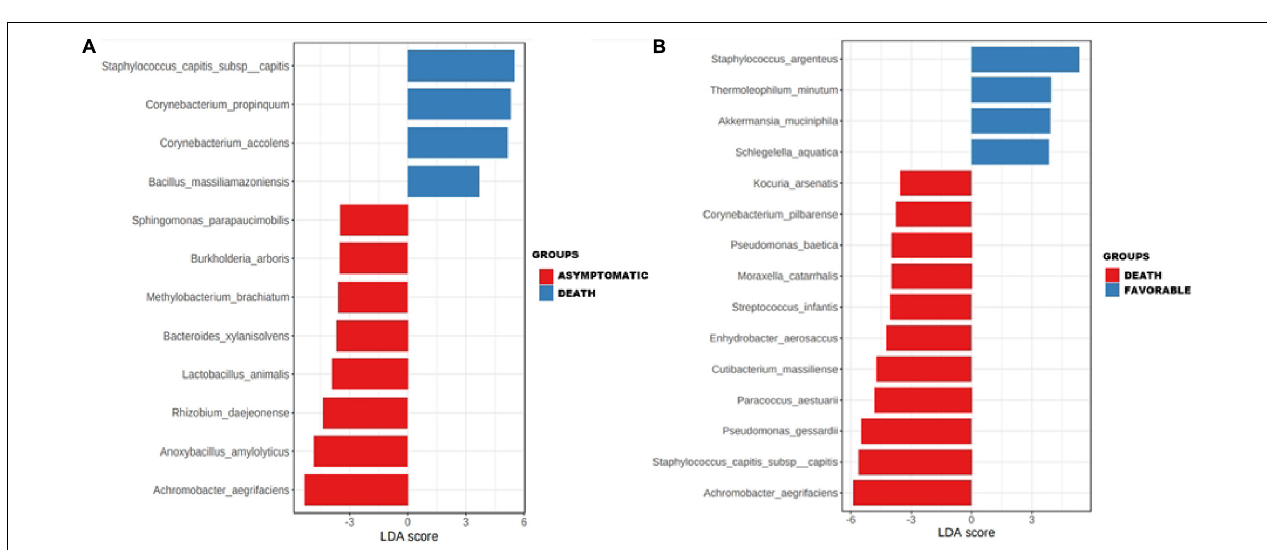
FIGURE 3 | Association of specific taxa in the airway microbiota of COVID-19 patients. Enrichments of specific taxa in the respiratory microbiota of COVID-19 patients in asymptomatic and deceased patients (A) and in deceased patients and patients with a favorable outcome (B) by linear discriminant analysis (LDA) effect size